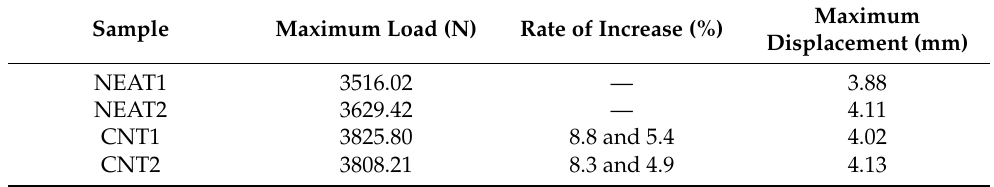
Table 6. The buckling load and vertical displacements of simple – simple supported samples.